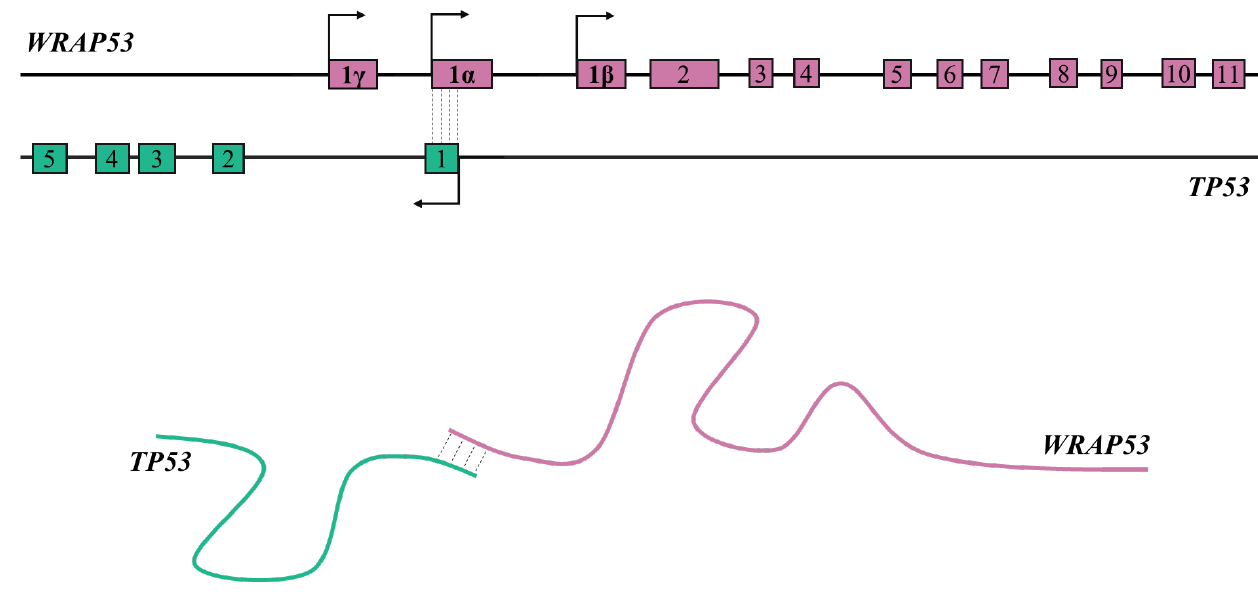
Figure 2. The WRAP53 and TP53 genes ( A ) and its RNAs duplex formation ( B ). The dotted lines demonstrate overlapping region between these genes ( A ) or created RNA duplex ( B ) and the arrows show the direction of transcription. Numbered regions indicate the coding sequences/exons of the WRAP53 and TP53 genes .